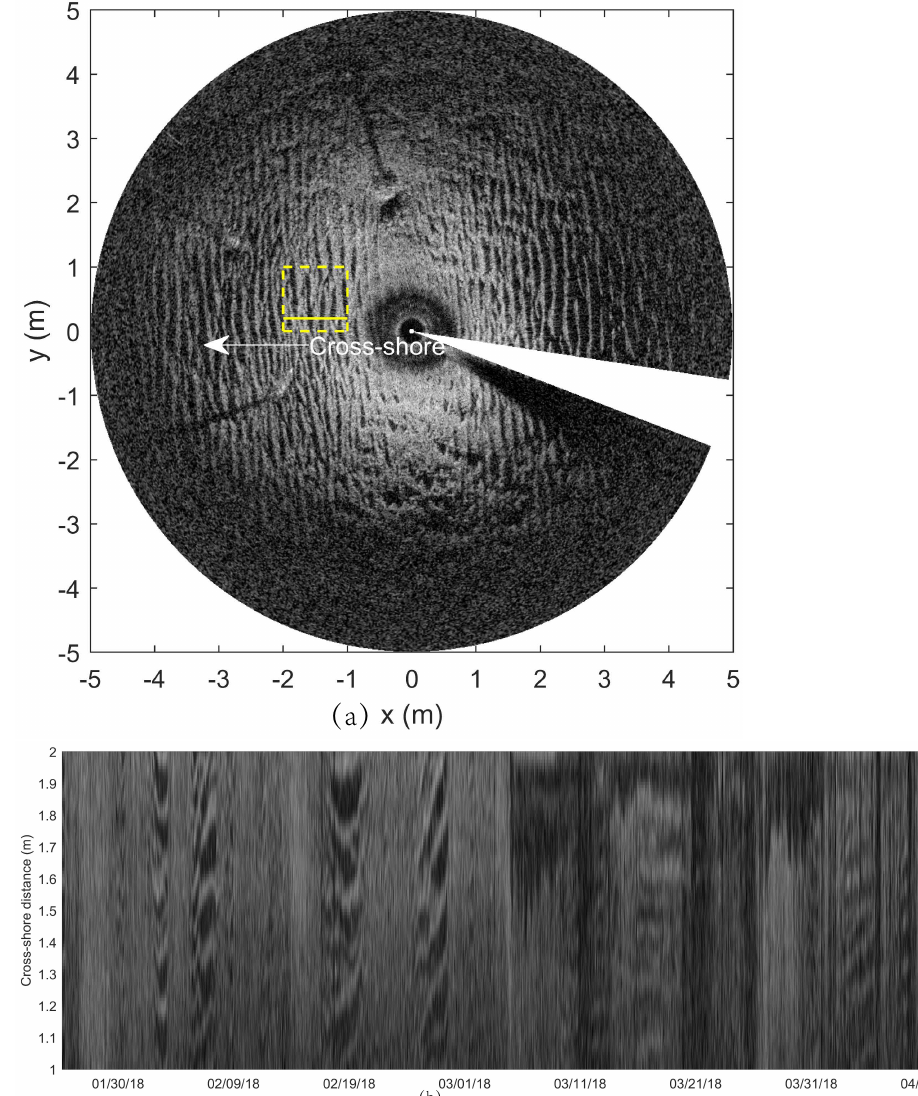
Figure 3. ( a ) Image from the rotary fan-beam corresponding to the first image captured on 3 February 2018 at Matanzas Inlet, Florida. The transect chosen for creating the time stacked image is indicated in bold yellow line and the square sub-patch is the region chosen for ripple wavelength calculation. ( b ) Time stacked image to calculate the ripple migration rate from the